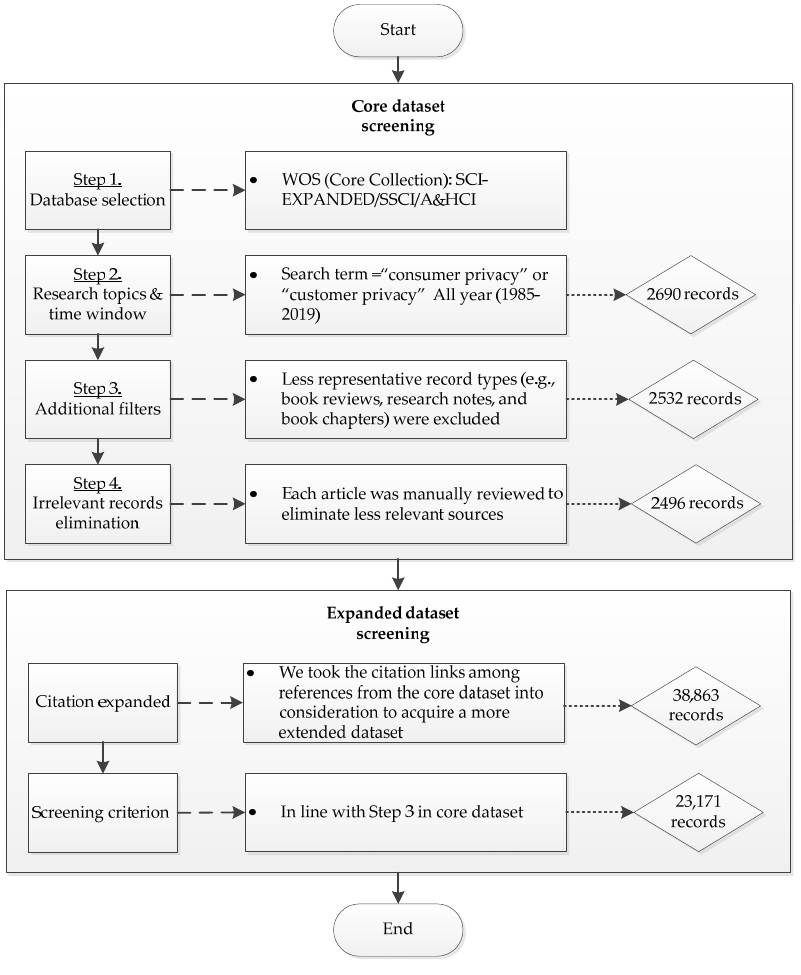
Figure 1. Data collection process.